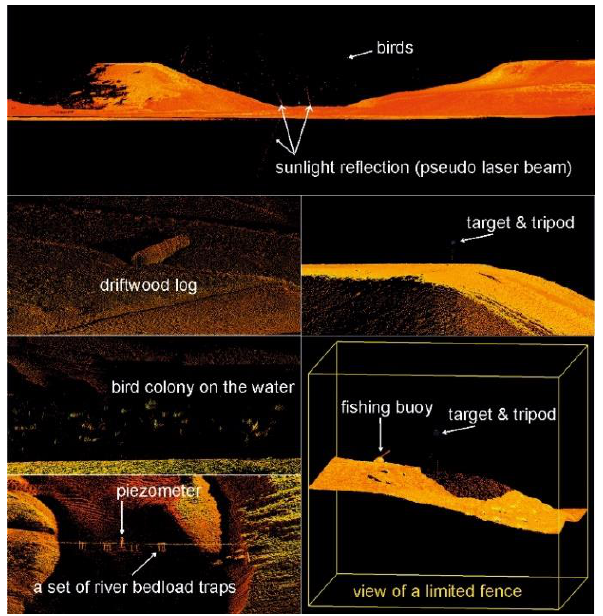
Figure 3. A few object types of the off-ground points in the raw point cloud.